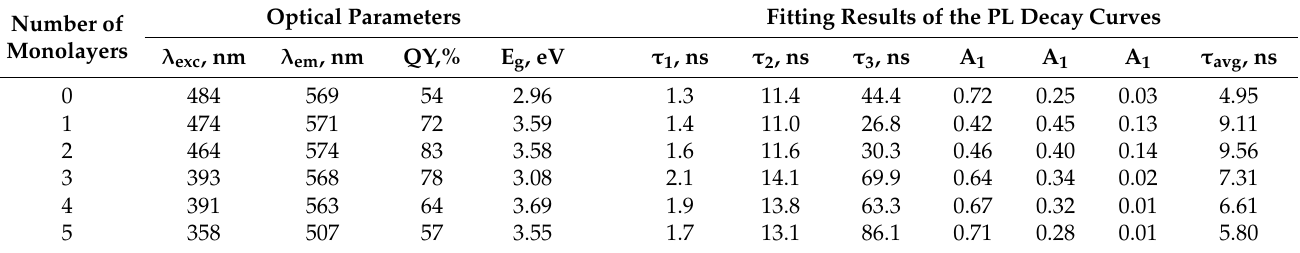
Table 2. Optical properties of core/shell Cd 0.25 Zn 0.75 Se/ZnS QDs and parameters of PL decay curves evaluation. Peak maximum in the PLE spectra ( λ exc ), peak maximum in the PL spectra ( λ em ), Stokes shift and band gap ( E g ); fitting results: time constants τ 1 , τ 2 , τ 3 ; amplitude components A 1 , A 2 and A 3 ; average lifetime τ avg . Fitting Results of the PL Decay